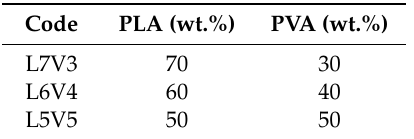
Table 1. PLA and PVA blending